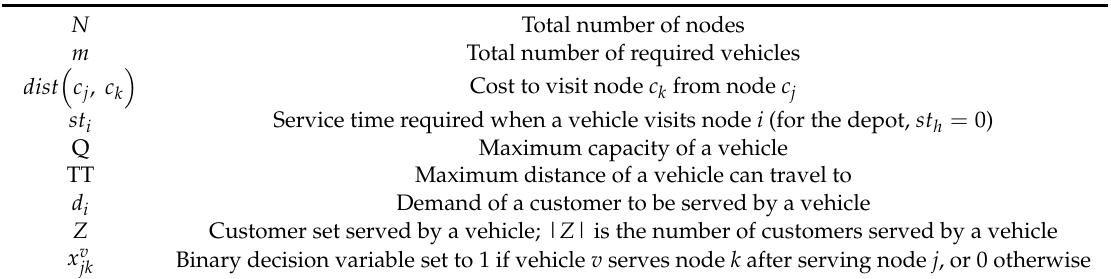
Table 1. Related notations and variables for CVRP formulation defined in this